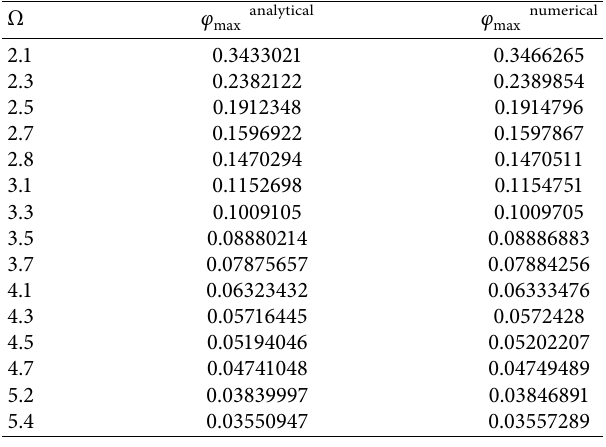
Figure 7: The numerical solutions for case (ii) in Section 4.1. Table 3: φ of the third case ( ] � 1 . 5 , μ � 5000 ) . max